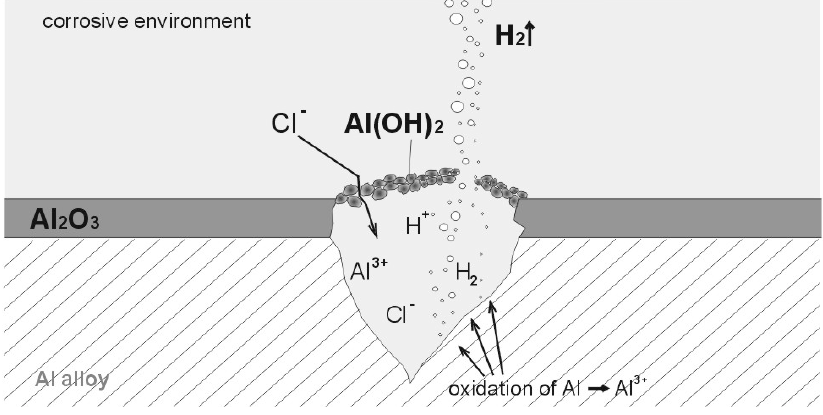
Figure 2. Diagram of pitting on passivated aluminum surface.